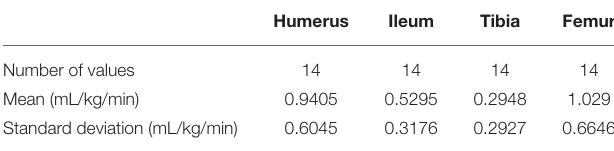
TABLE 5 | Gravity infusion rates.